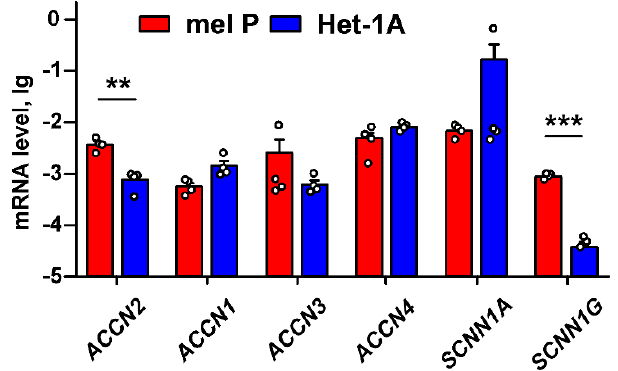
Figure 3. qPCR analysis of the ACCN2 , ACCN1 , ACCN3 , ACCN4 , SCNN1A, and SCNN1G expression in the patient-derived mel P melanoma cells and keratinocytes Het-1A. Gene expression was normalized to the β -ACTIN, GPDH, and RPL13a housekeeping genes and presented as lg of relative